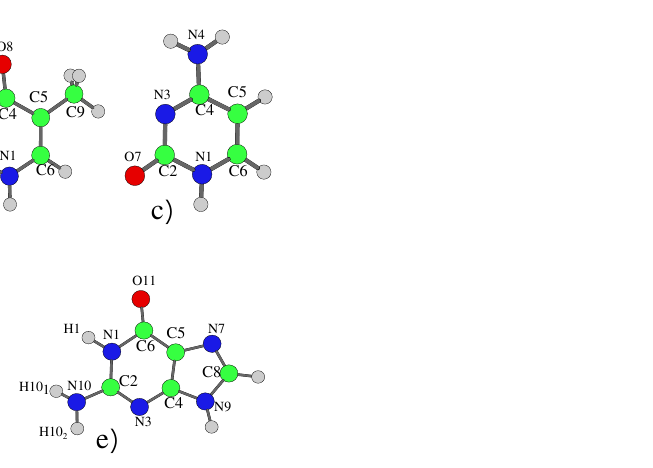
Figure 1. Schematic description (and atom labeling) of the five nucleobases: ( a ) Uracil, ( b ) Thymine, ( c ) Cytosine, ( d ) Adenine and ( e ) 9H-Guanine. In the 7H tautomer the hydrogen atom is bonded to the N7 Nitrogen atom rather than